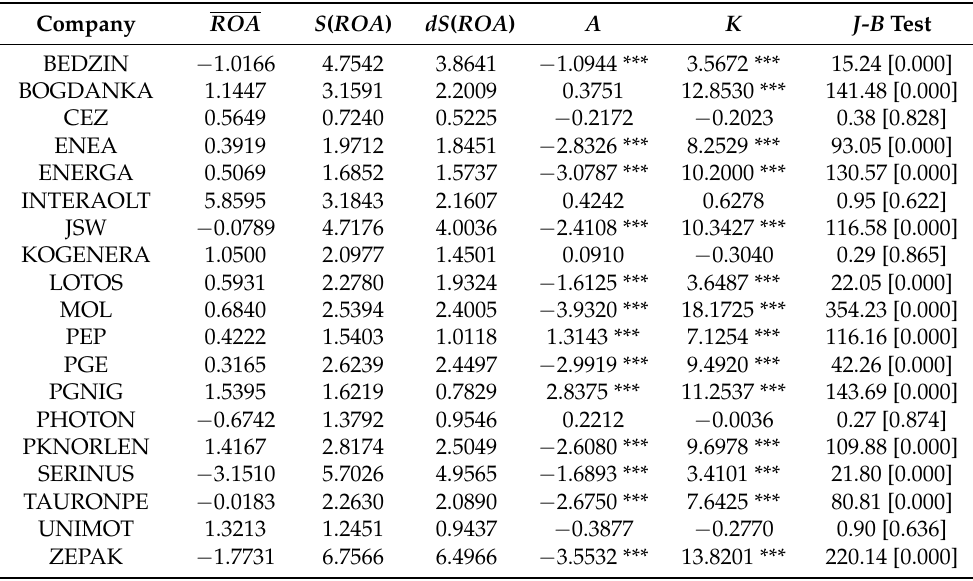
Table 5. Summary statistics of energy companies’ quarterly